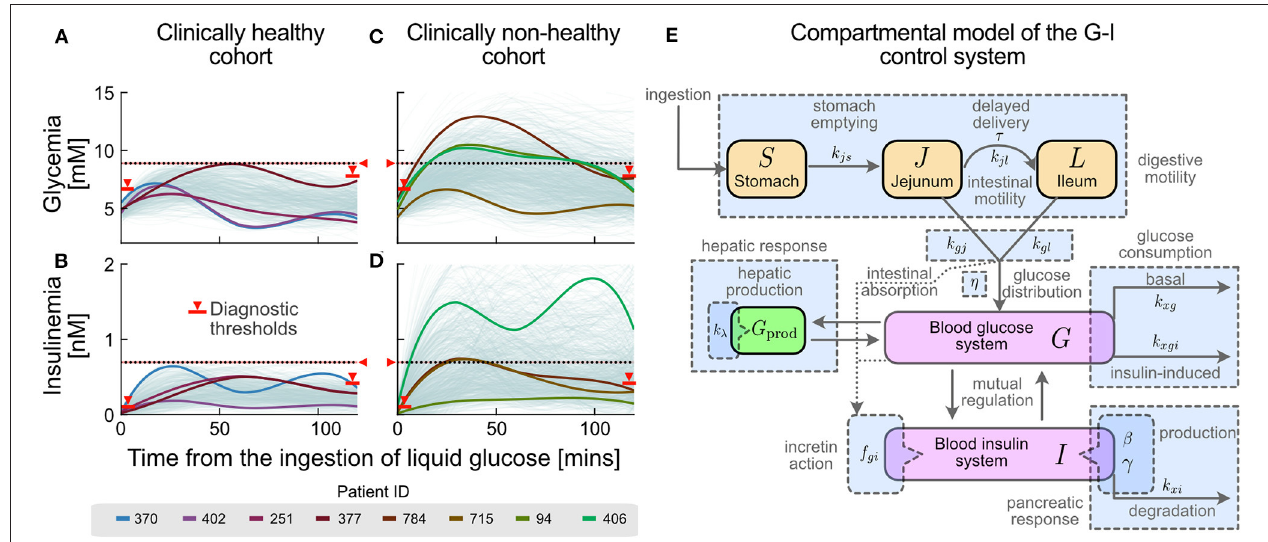
FIGURE 1 | Different glucose-insulin (G-I) curve shapes are masked under the current clinical criteria of normality. Current clinical criteria classify an individual as healthy (A,B) or non-healthy (C,D) based on threshold values for their OGTT response (see Methods and Supplementary Table S1 ). Red markers and horizontal lines in both glycemia-insulinemia represent current criteria of normality for an OGTT, including basal (pre-prandial), final (2-hr) and all-time maxima. Different colours represent selected individual subjects in the healthy (A,B) and non-healthy (C,D) cohorts whose glycemia curves are similar, but having different insulinemia curves (subjects 370/402 and 94/406), or similar insulinemia curves but different glycemia curves (subject 251/377 and 784/715). (E) G-I dynamics during an OGTT can be represented by a compact compartmental mathematical model (23), where the main physiological processes in G-I dynamics are represented as subsystems. Compartments are represented by coloured boxes (orange for glucose pools in the lumen of the digestive system, magenta for blood concentrations and green for the liver compartment). Rate constants and parameters for each physiological process are indicated alongside their respective process arrows or compartments. General related processes, which account for subsystems, are shown as blue